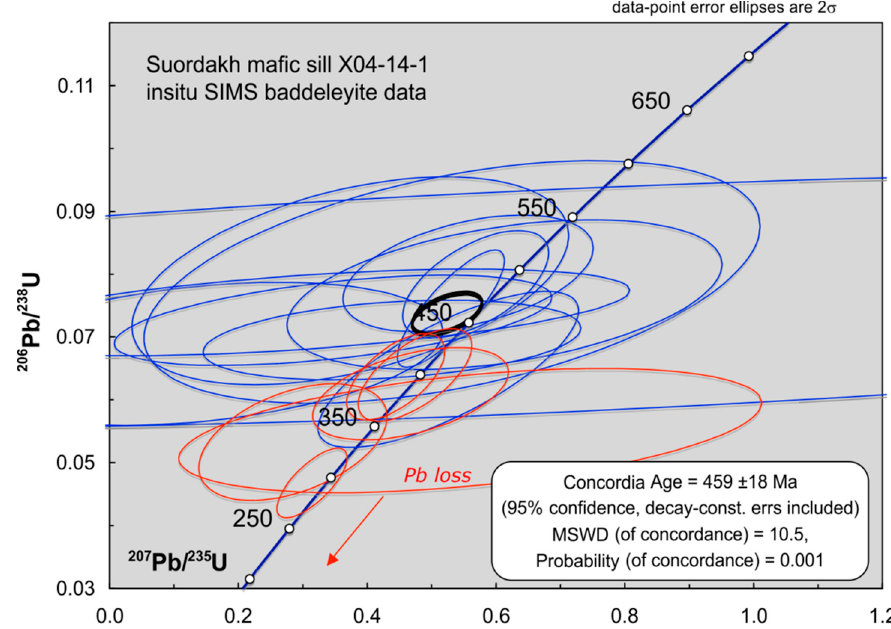
Figure 5. Concordia plot of in-situ SIMS U-Pb analyses from X04-14-1. Blue ellipses overlap Concordia and each other with a Concordia age [36] of 459 ± 18 Ma (small black ellipse). The red ellipses also overlap Concordia but had younger 206 Pb/ 238 U dates and were excluded from the date calculations. These were interpreted to reflect minor, recent, bulk Pb loss and/or alteration.